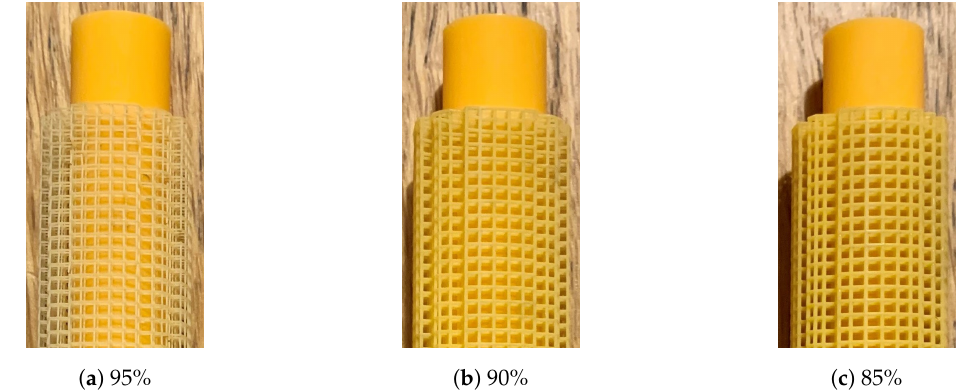
Figure 4. Porous coatings with constant lattice size and variable